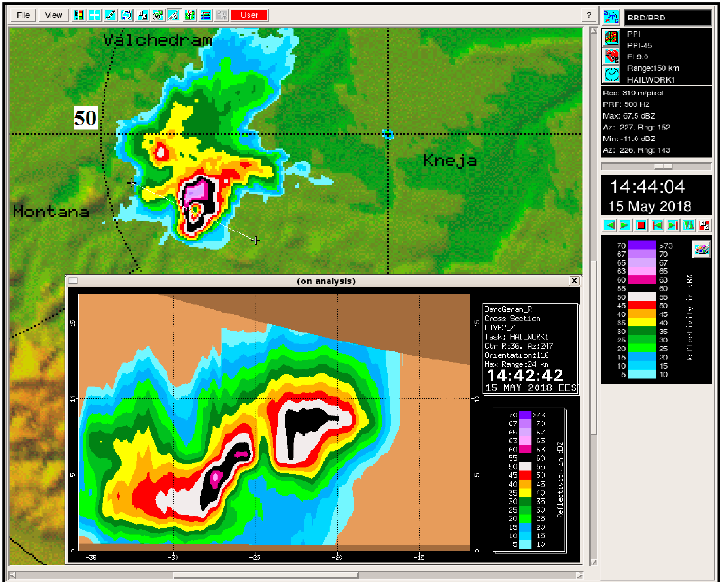
Figure 4. A plan position indicator (PPI) reflectivity image (9° elevation angle) and a vertical cross section through the bounded weak echo region (BWER) region of the supercell at 11:44 UTC.